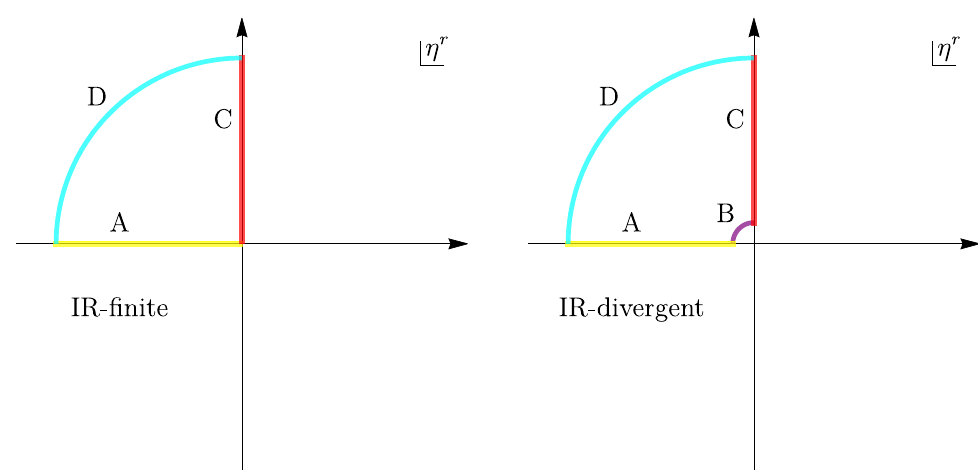
Figure 3 . Integration contours in complex η r plane. A similar contour in the lower-half complex plane applies to the left